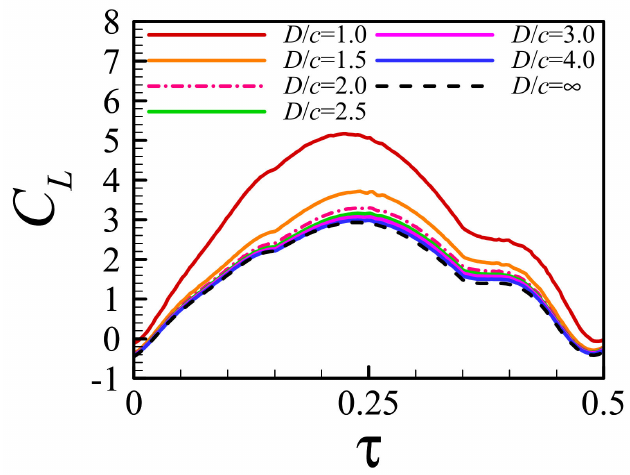
Figure 7. The transient aerodynamic lift coefficient ( C L ) distributions for the first downstroke at systematic wall clearances ( D / c ) and Re = 10.